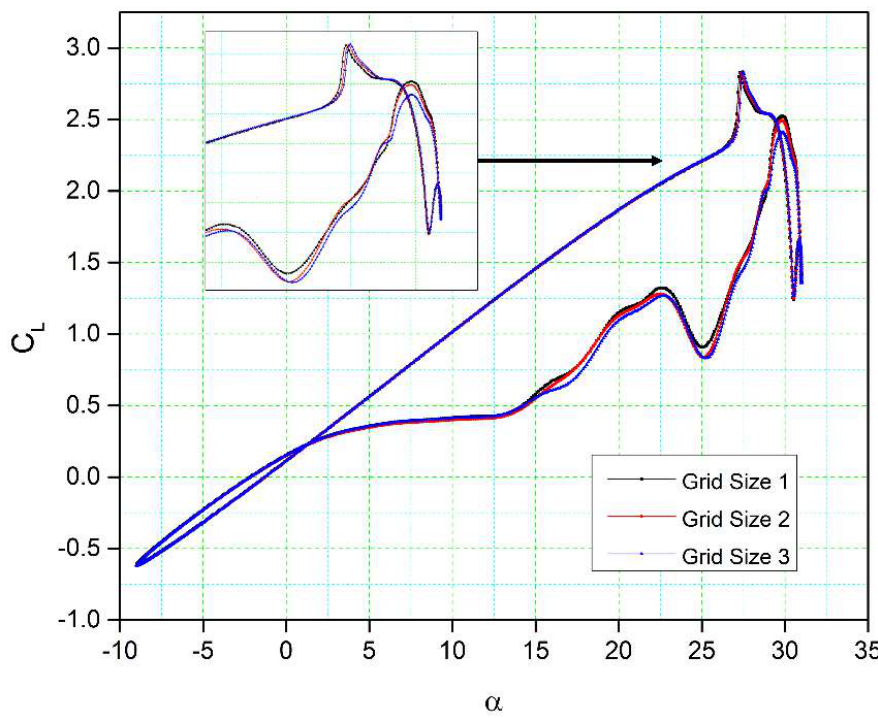
Figure 5. Comparisons of the numerical results for the lift coefficient versus the angle of attack for three different grid sizes.